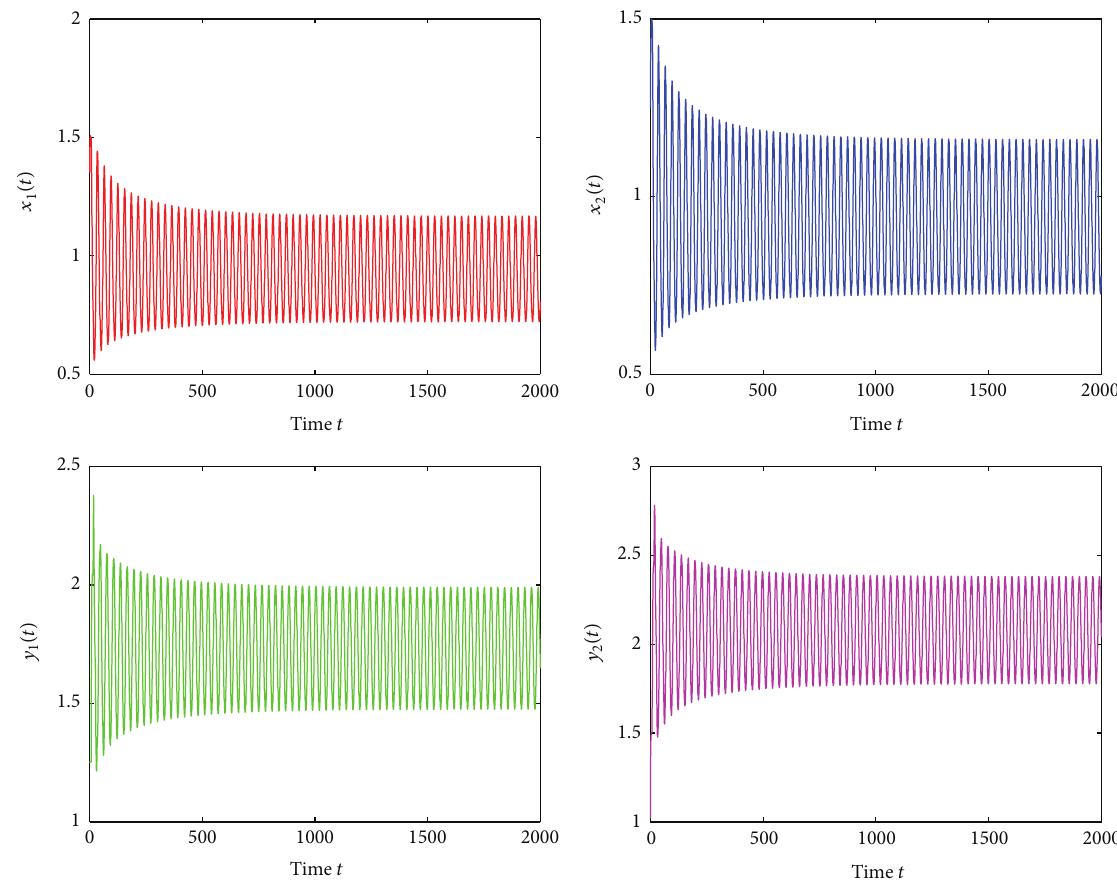
Figure 22: The track of the states 𝑥 1 , 𝑥 2 , 𝑦 1 , 𝑦 2 for 𝜏 2 = 7.5000 > 𝜏 ∗ 2 = 6.6494 and 𝜏 ∗ 1 = 2.5000 .